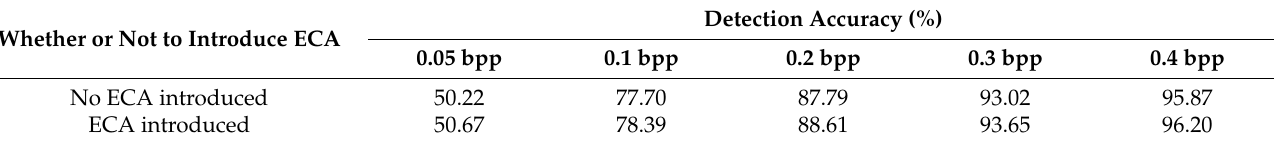
Table 3. Effect of the attention mechanism on model accuracy when using the WOW